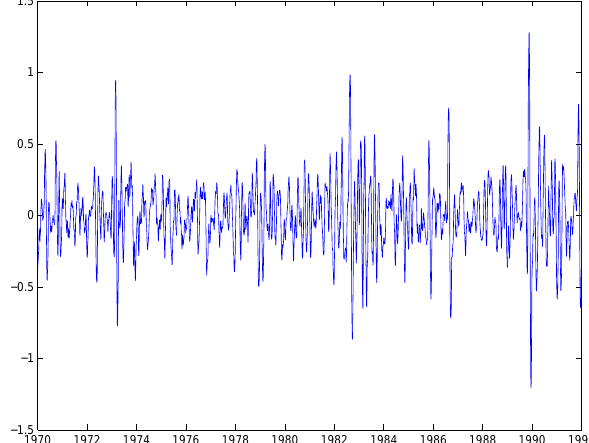
Fig. 1. Modulus of the transfer function F(v) (Eq. (2) of main text), with p = 61. The bold line represents the transfer function of the simple first derivative; the dashed line and the dashed-dotted line correspond to frequencies of, respectively, 1 year and 6 months.